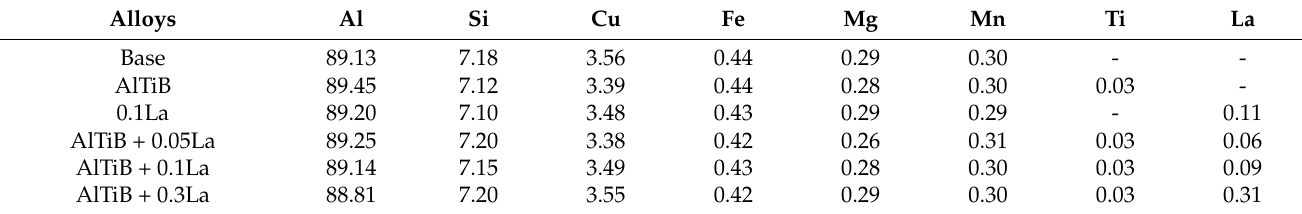
Table 1. Chemical compositions of the aluminum alloys (wt.%).